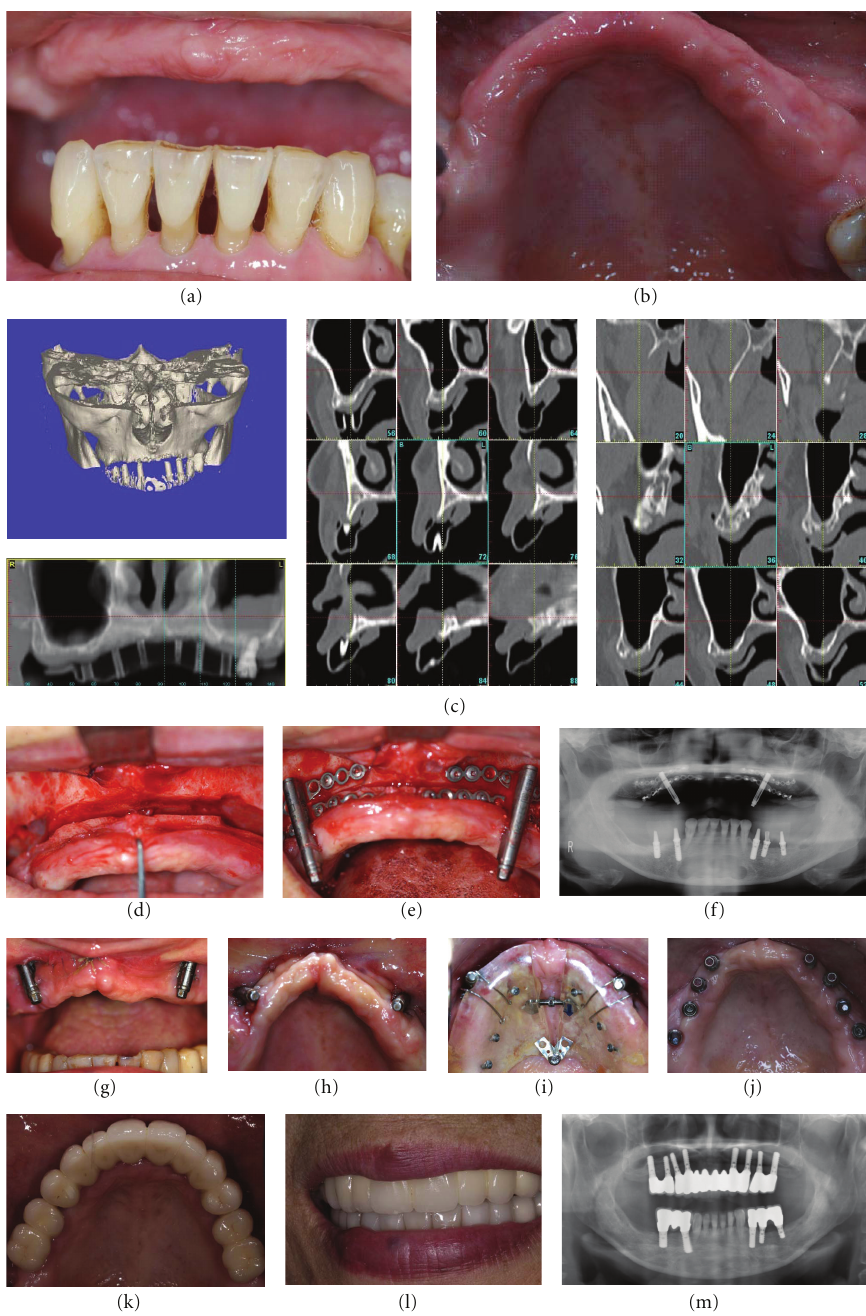
Figure 2: Representative case of bilateral sinus lifting and simultaneous total alveolar distraction for an edentulous severely atrophic maxilla (Case 2, Table 1). (a, b) Preoperative intraoral views; (c) preoperative CT views; (d) intraoperative view. After the end of the bilateral sinus floor elevation and completion of the total alveolar osteotomy: (e) su ffi cient sinus lifting with an equal-volume mixture of particulate autogenous cancellous bone/ β -TCP was observed and the bilateral alveolar distractors were set; (f) postoperative panoramic X-ray; (g) after the end of vertical distraction; (h) good vertical distraction was obtained, but the maxillary alveolar arch was very narrow and V- shaped; (i) bilateral alveolar segmental widening with distraction was followed with use of an orthodontic palatal expansion device (the Hyrax device); (j) implant placement at ideal positioning was obtained for dental implant-anchored fixed prosthetic rehabilitation; (k, l) the definite prosthesis was set after 2 years with a provisional restoration during the postloading period for total oral rehabilitation; (m) panoramic X-ray taken 3 years